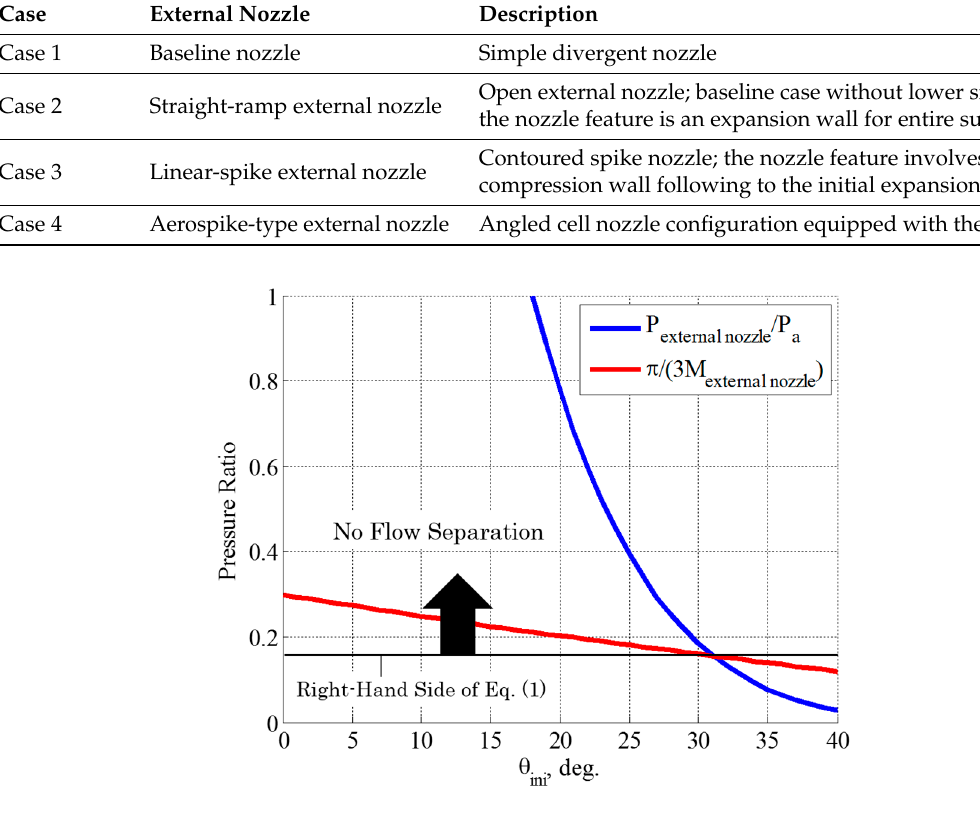
Figure 3. Separation conditions plotted against the initial inclination angle of the external nozzle. Table 2. Summary of external nozzle configurations.